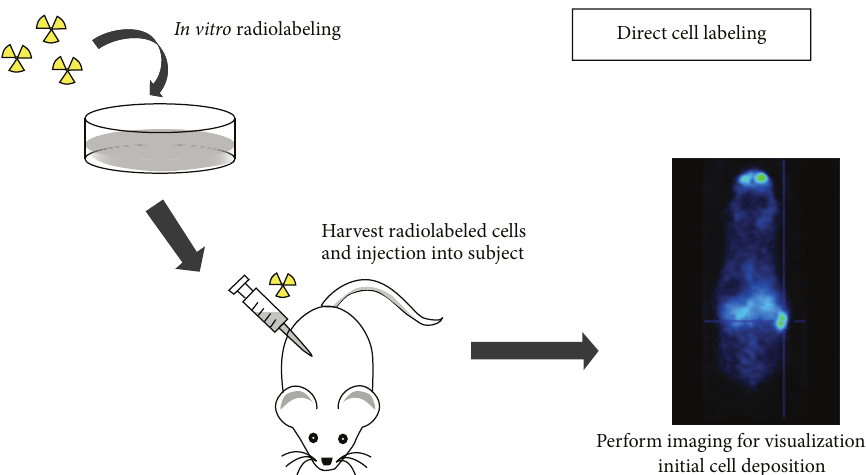
Figure 1: Schematic overview of the processes involved in direct cell labeling. Cells are first labeled with contrast agents in vitro through incubation, harvested, and injected into a subject (adapted from